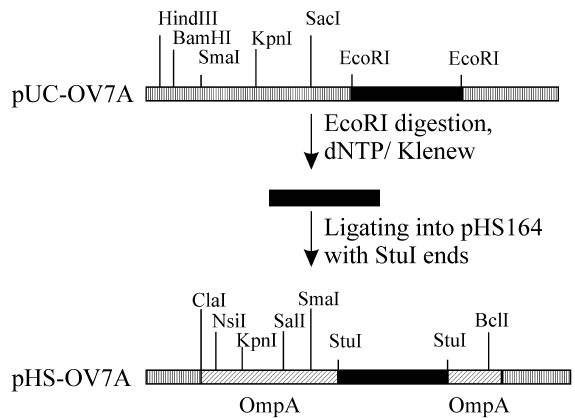
Figure 1 - The subcloning strategy used to generate the pHS-OV7A con- struct with an open reading frame of OV7A continuous with the 5’ end of the OmpA gene in the pHS164 vector.